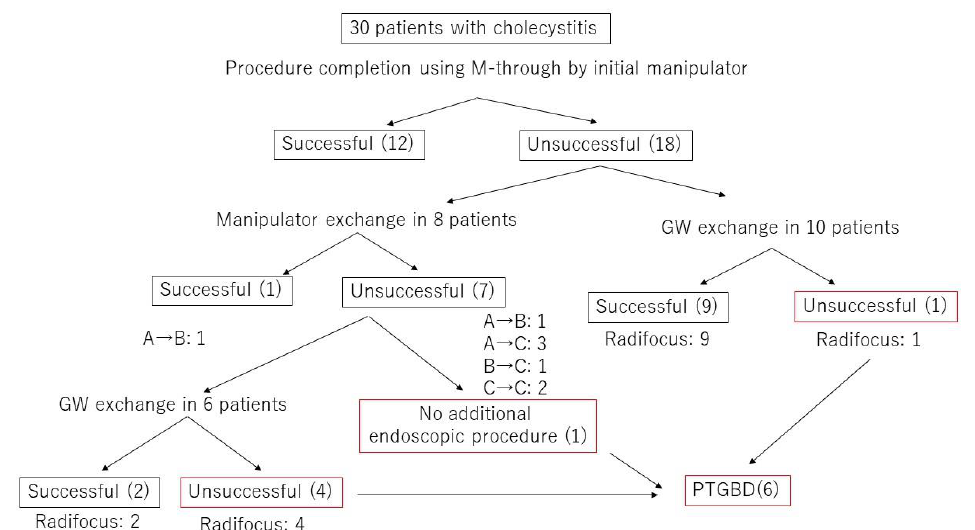
Figure 4. Flowchart of the procedural details including GW and/or manipulator exchange in cholecystitis cases.Experience level of GW manipulator; A was defined as less than five years of experience, B as five years or more but less than 10 years, and C as 10 years or more.